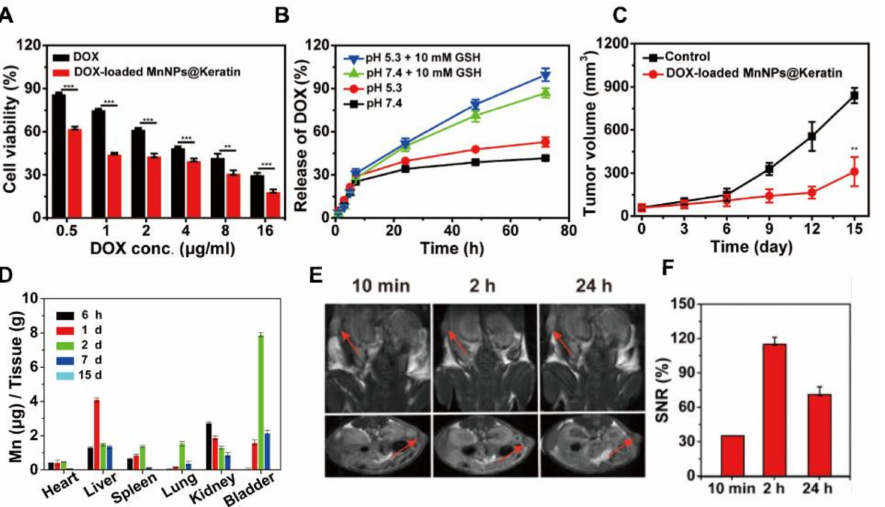
Figure 12. ( A ) Cell viability of 4T1 incubated with different concentrations of DOX and DOX-loaded MnNPs@Keratin by CCK-8 assay; ( B ) release profiles of DOX from DOX-loaded MnNPs@Keratin under varying conditions mimicking the normal fluid and tumor environment; ( C ) tumor volume growth curves of 4T1 tumor-bearing mice after treatment with DOX-loaded MnNPs@Keratin. The mice without treatment were used as control. ** p < 0.01; *** p < 0.001; ( D ) In vivo biodistribution study; ( E ) T1-weighted MR images of 4T1 tumor-bearing mice after 10 min and 2 and 24 h administra- tions of MnNPs@Keratin (100 µ L, 33 mg/mL). Top is coronal images, and bottom is transverse images. The tumor regions are marked with red arrows; ( F ) T1-weighted MR signals (SNR) in the tumor calculated according to the transverse MR images. Adapted with permission from [75]. Copyright 2021 American Chemical